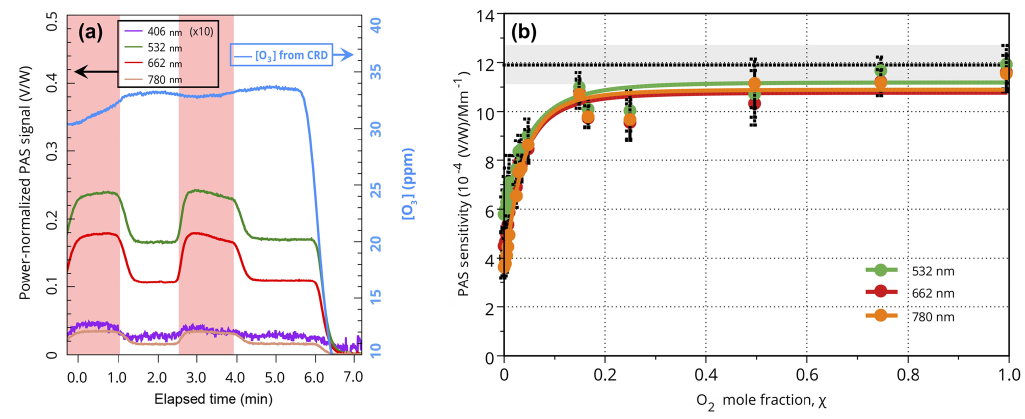
Figure 4. (a) Time series of O 2 addition; (b) PAS signal (normalized to absorption cross section) as a function of O 2 mole fraction, χ . Red shaded regions in (a) represent times when 5% oxygen was added to the sample stream. Error bars in (b) are ± 1SD of a 30s average. The black line in (b) represents the value obtained with NO 2 with the gray shaded region representing the 3 σ uncertainty, and the colored lines are the best fit to the data using Eq.